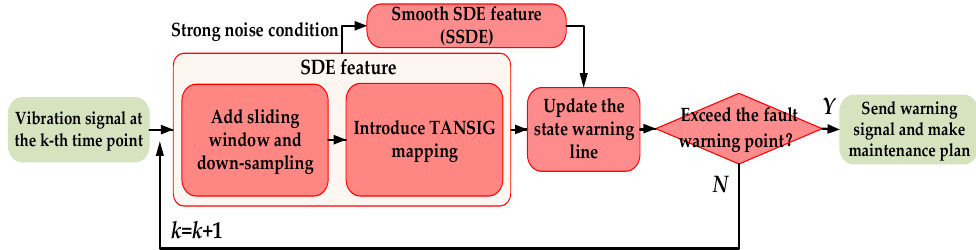
Figure 3. Flow chart of fault state detection and evaluation method.